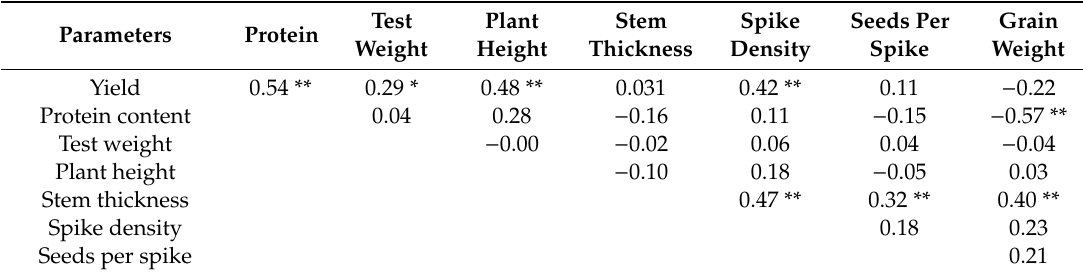
Table 4. Pearson correlation coe ffi cients among yield, protein content, test weight, plant height, stem thickness, spike density (ear m − 2 ), seeds per spike, and grain weight for SY-Ovation across two growing seasons in Columbia Basin of Oregon ( n =